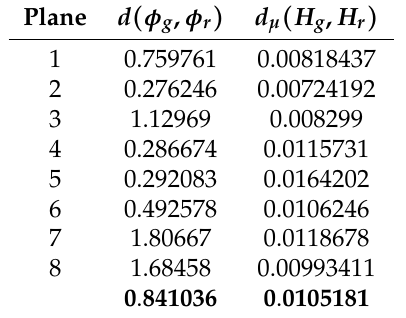
Figure 14. 2D projection on the ground plane of both the reconstructed and the ground truth 3D model in order to evaluate the accuracy qualitatively. To obtain the image, the ground plane was removed from both point clouds, and a quantization in 2D cells was conducted. Brighter areas denote a higher point density in the cell and, hence, emphasize the overlap of both point clouds. Visually, one can notice little to no discrepancies as the walls and edges of both models are overlapping. Table 2. The difference in angle between two corresponding planes φ ( H s , H t ) (cid:44) acos ( n s · n t ) (in degrees) and the average distance of two corresponding planes d ( H s , H t ) (cid:44) 1 (in meter) for the eight most dominant planes in the